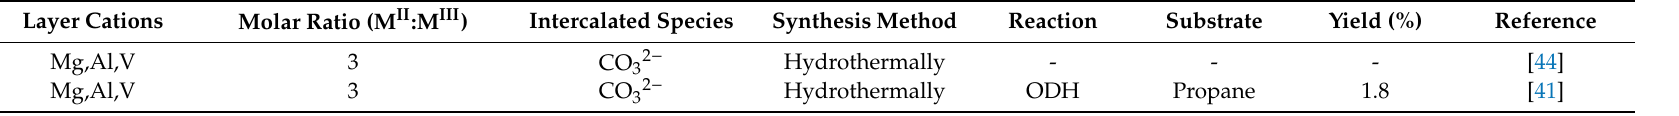
Table 5. Summary of M II M III